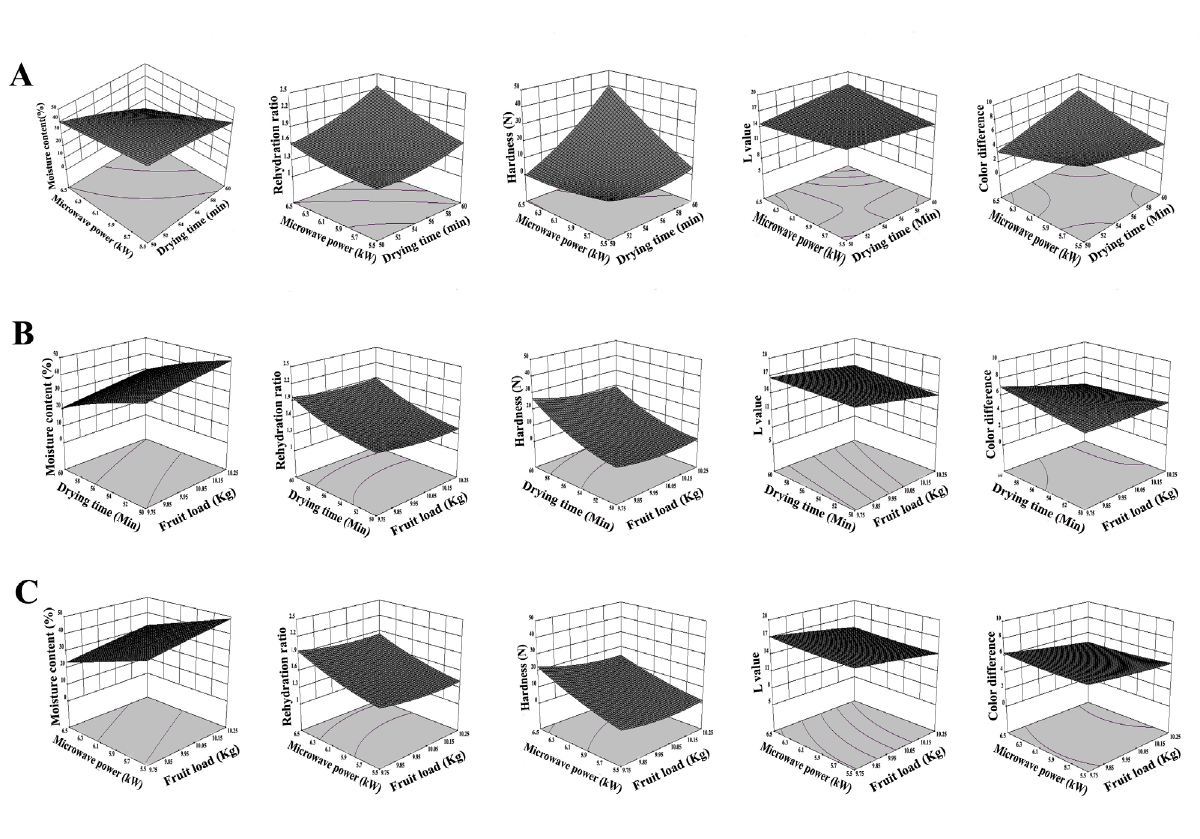
Figure 2 Effect of microwave power and drying time (A), effect of drying time and fruit load (B) and effect of microwave power and fruit load (C) on moisture content, rehydration ratio, hardness, L value and total color difference of the microwave-vacuum dried Saskatoon